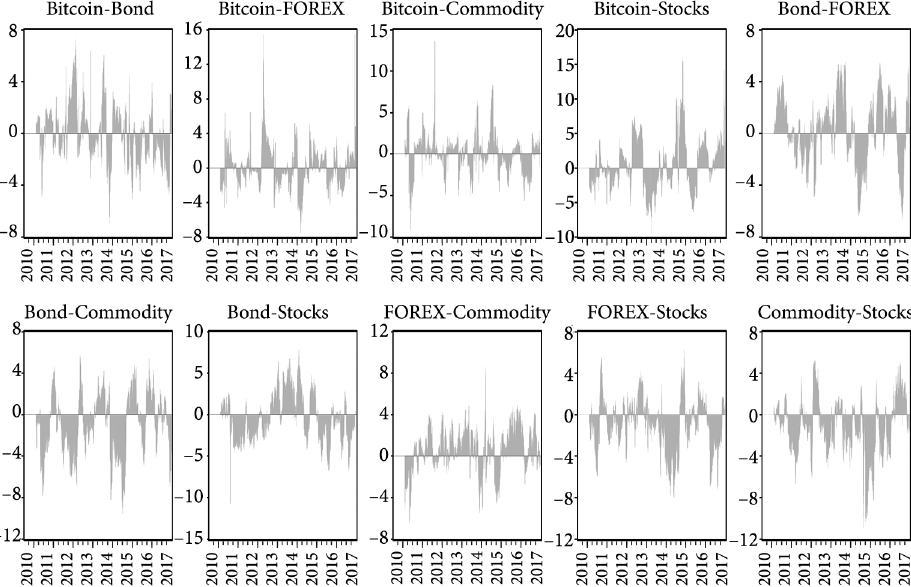
Figure 5. Net pairwise volatility